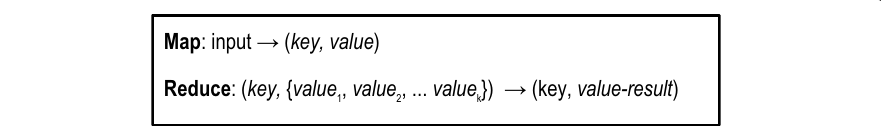
Fig. 1 A format of basic Map and Reduce functions. Shown a basic data format of Map and Reduce